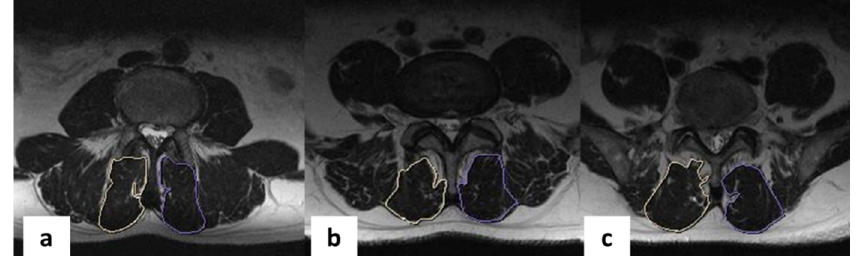
Figure 6. Axial MRI scans of the lumbar spine, the right multifidus muscle is outlined in white, the left multifidus muscle is outlined in purple: ( a )—L3–L4; ( b )—L4–L5; ( c )—L5–S1. left multifidus muscle is outlined in purple: ( a )—L3–L4; ( b )—L4–L5; ( c